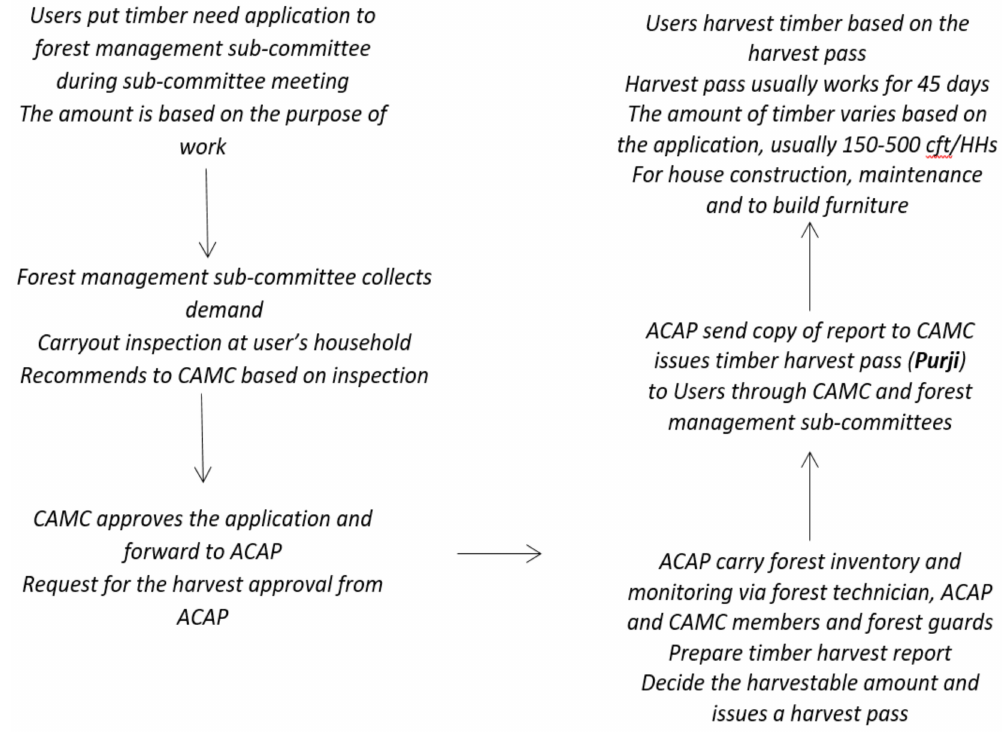
Figure 4. Flow of decision making in timber harvesting